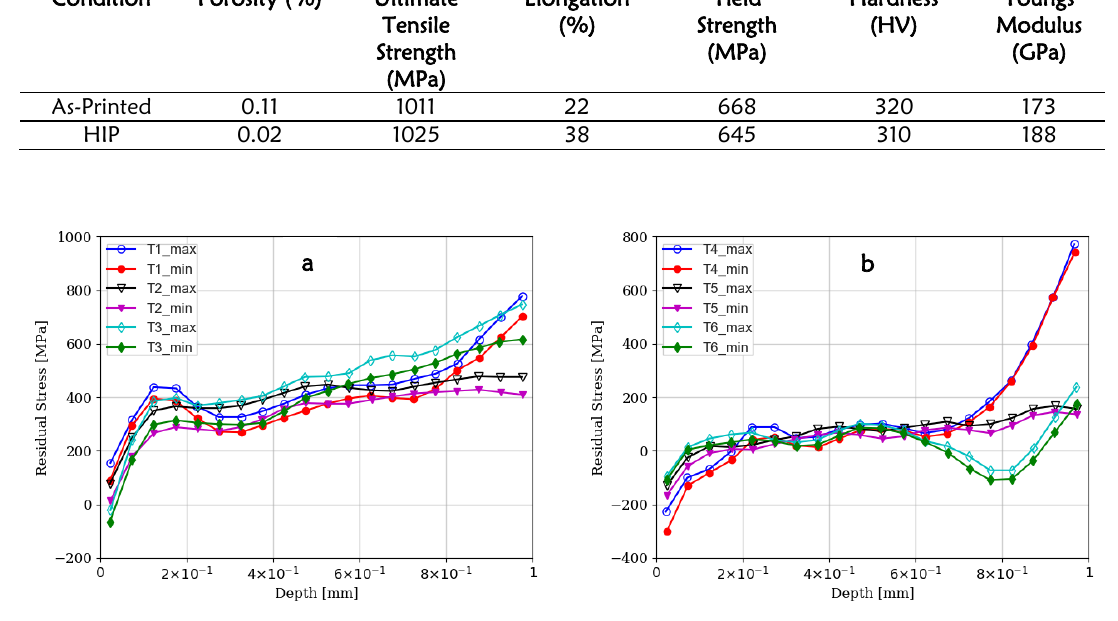
Figure 20: Residual stress profiles in SLM IN718 (a) As printed and (b) after stress relieving. T: location, numbers (1-6): specimen identification [54]. Note different scales for stress in both